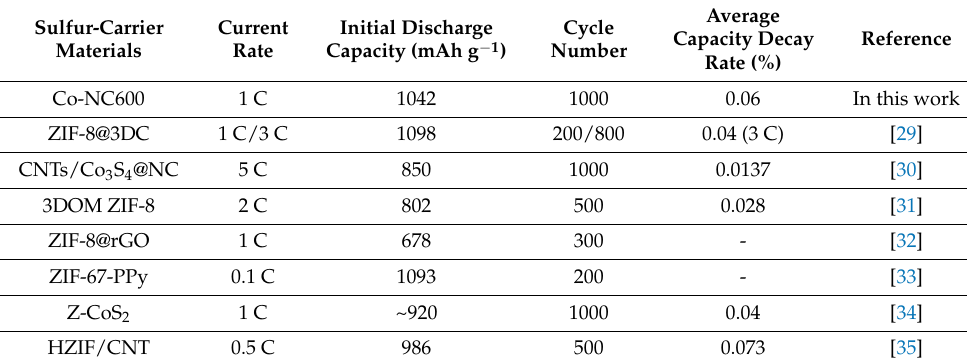
Table 1. The performance of various ZIF-derived materials as sulfur-carrying materials reported in the